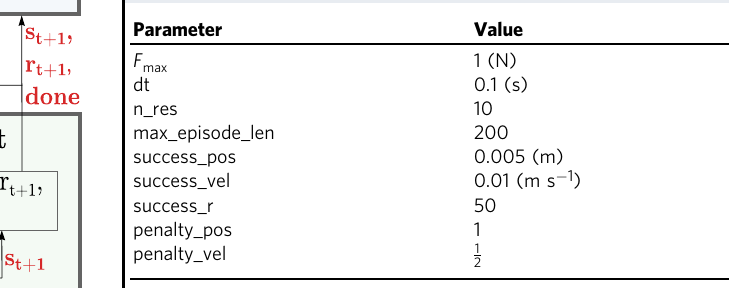
Table 3 Environment parameters.